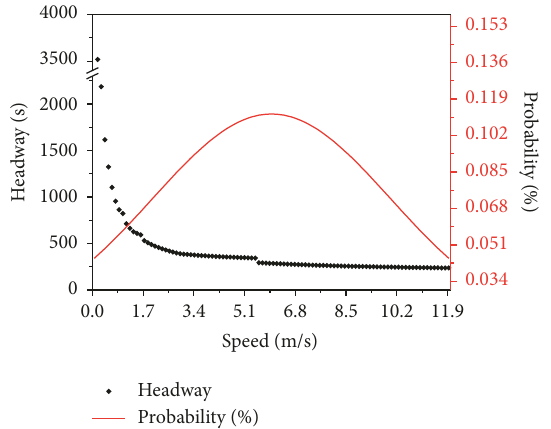
Figure 8: Bus headways and their probabilities for different speeds.